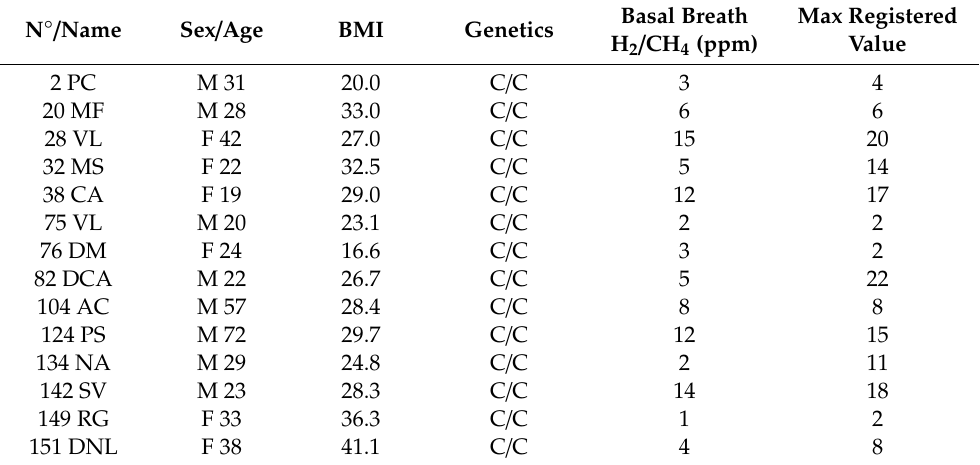
Table 2. Anagraphic, morphologic, and breath test details of the 13 C / C subjects in whom LBT and genetics are not congruent. Genetics